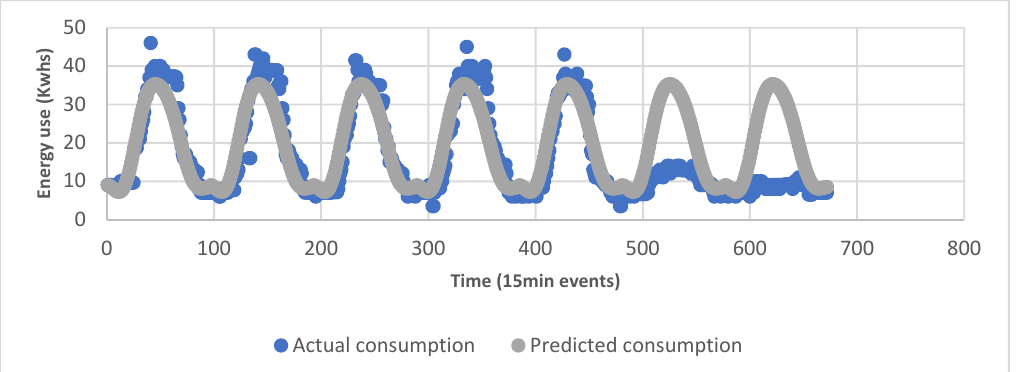
diction, to actual consumption and the unsegmented predicted consumption, in the first week of autumn. tion and the unsegmented predicted consumption, in the first week of autumn. autumn.